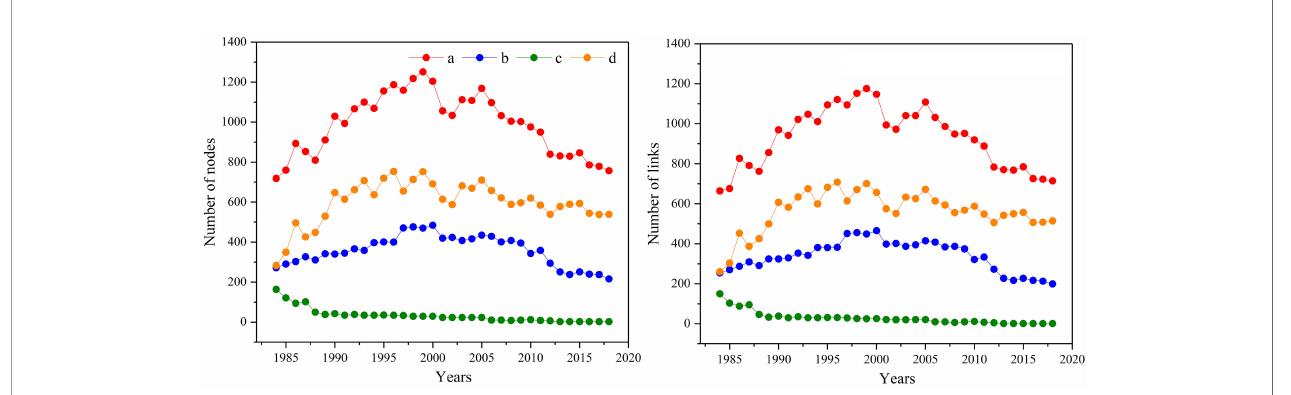
FIGURE 3 | Nodes and links dynamic during 1984-2018 (a represent the whole scale, b, c and d represent erosion zone, oil fi eld zone and deposition